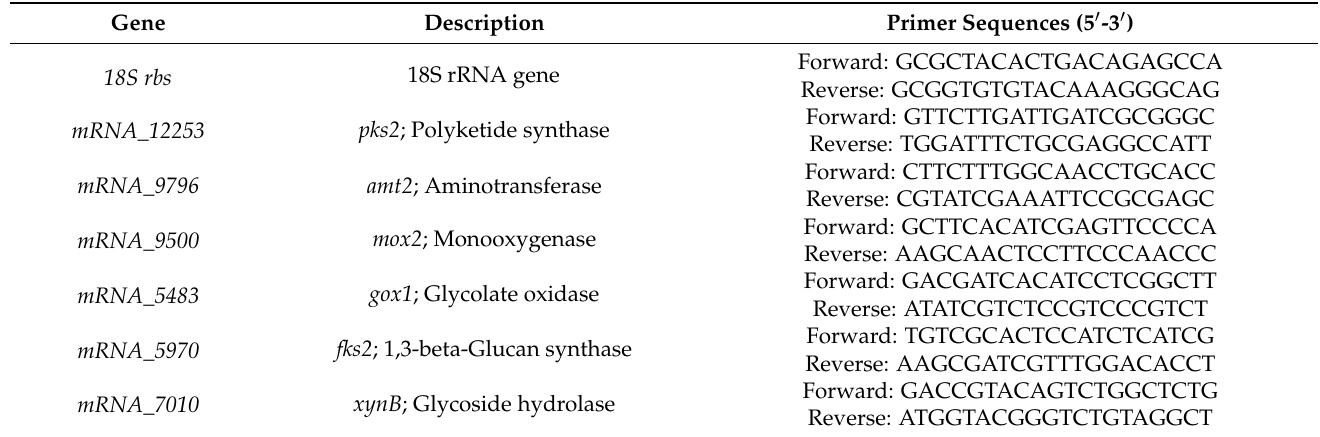
Table 1. The list of primers for qRT-PCR